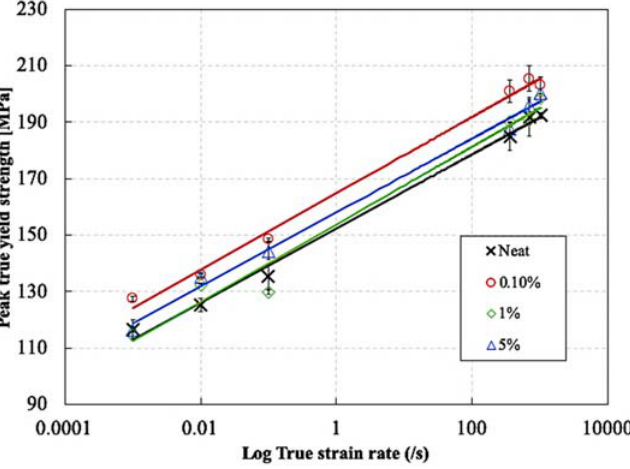
Figure 17. Effect of strain rate on the peak true yield strength neat epoxy resin and different weight Figure 17. E ff ect of strain rate on the peak true yield strength neat epoxy resin and di ff erent weight content of hyperbranched polymers (HBPs). content of hyperbranched polymers